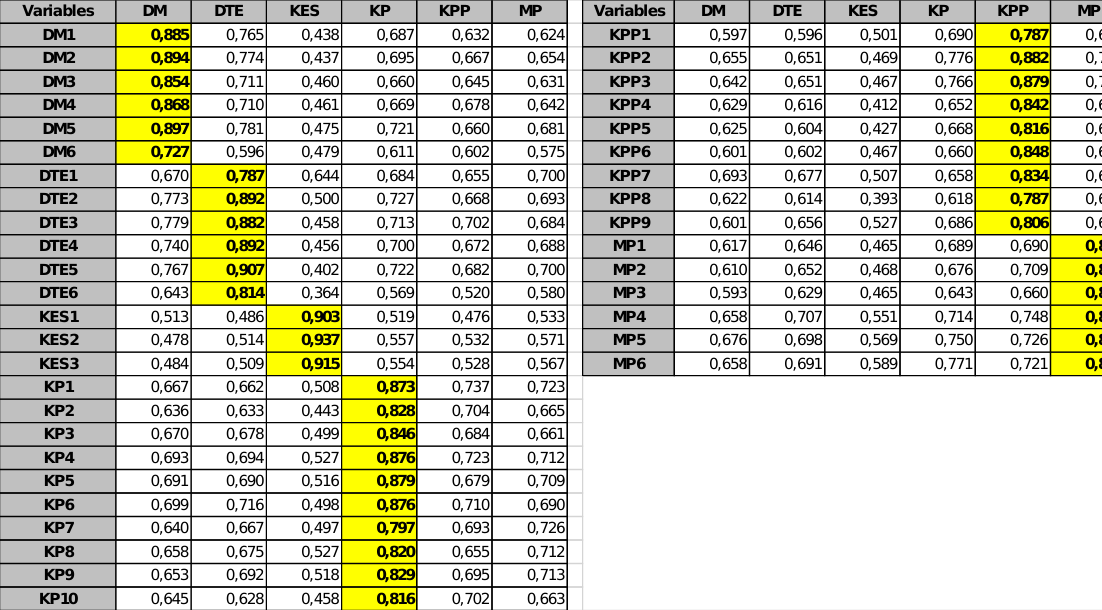
Table 2: Discriminant Validity Test Results